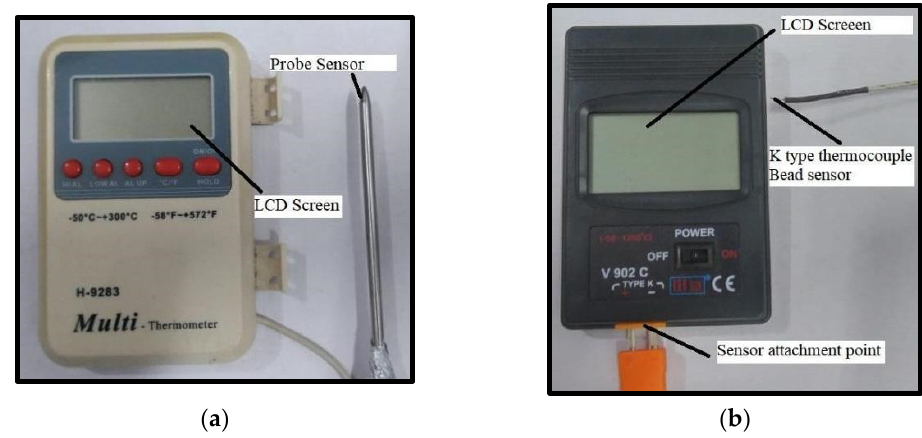
Figure 4. ( a ) Temperature measuring device up to single decimal place. ( b ) Temperature measuring